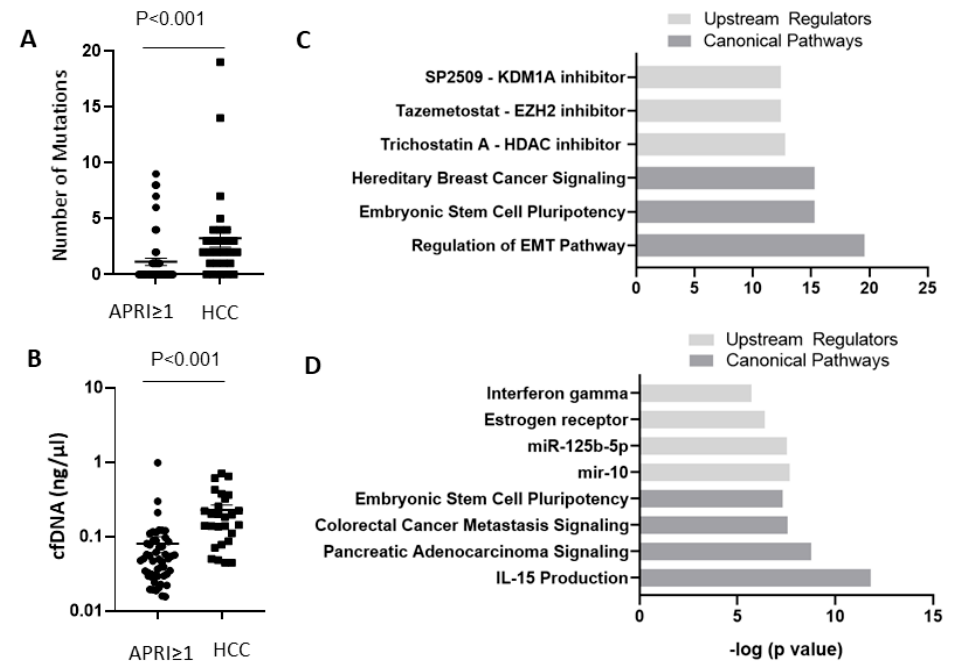
Figure 5. Hispanic patients with HCC have high numbers of mutations ( A ) and higher concentra- tions of cfDNA ( B ) compared to Hispanic subjects with APRI ≥ 1. Data are presented as mean ± SEM. ( C , D ) IPA core analysis identified top canonical pathways and top upstream regulators for mutated genes in cfDNA of Hispanic subjects with HCC ( C ) and mutated genes in cfDNA of Hispanic sub- jects with APRI ≥ 1 ( D ). APRI, Aspartate transaminase to Platelet Ratio